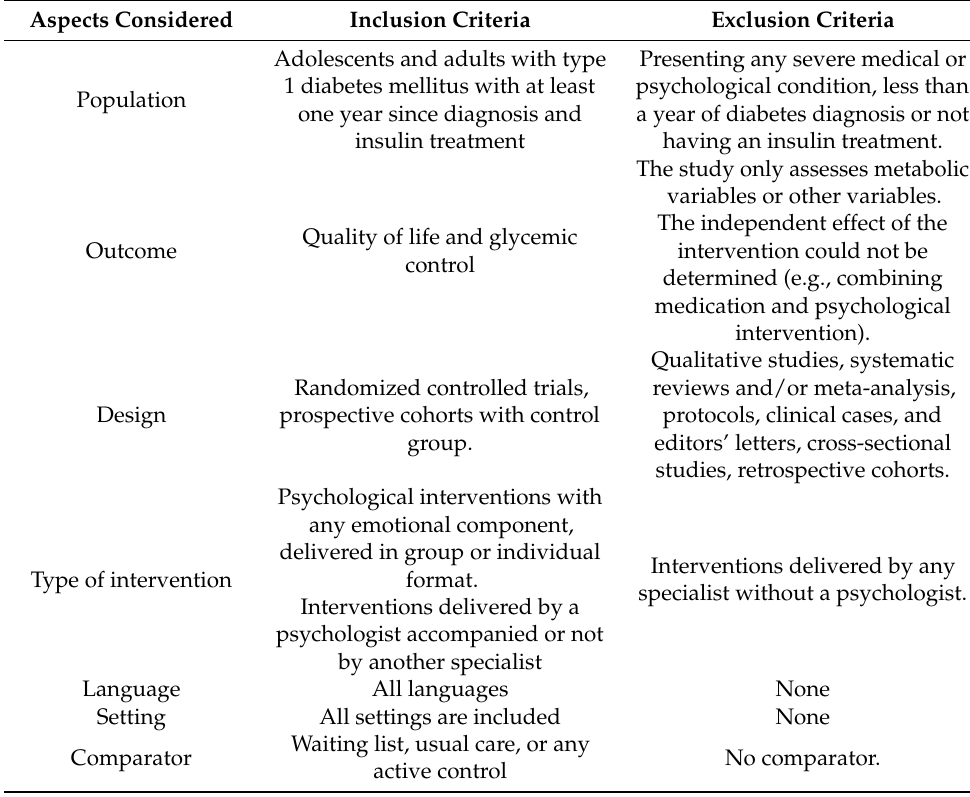
Table 1. Inclusion and exclusion criteria for the studies included in the